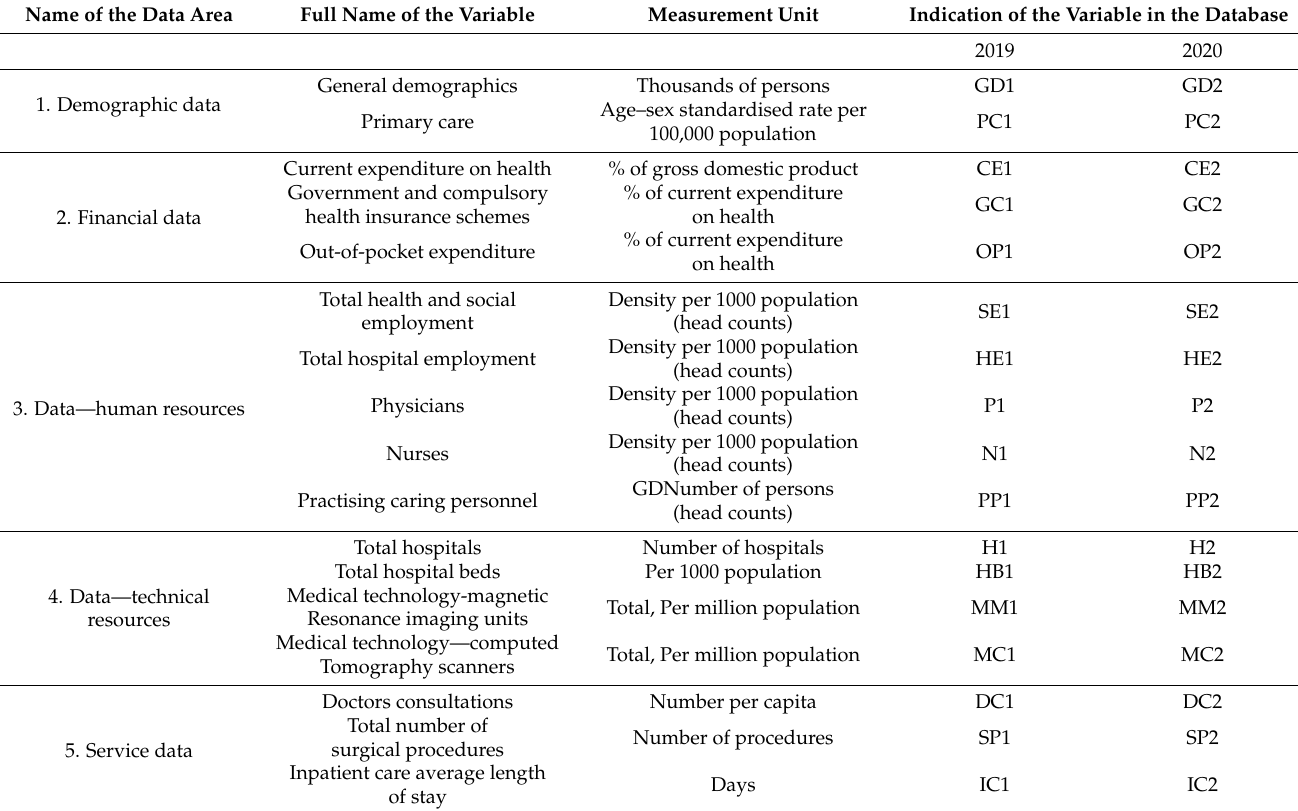
Table 2. Characteristics of the set of